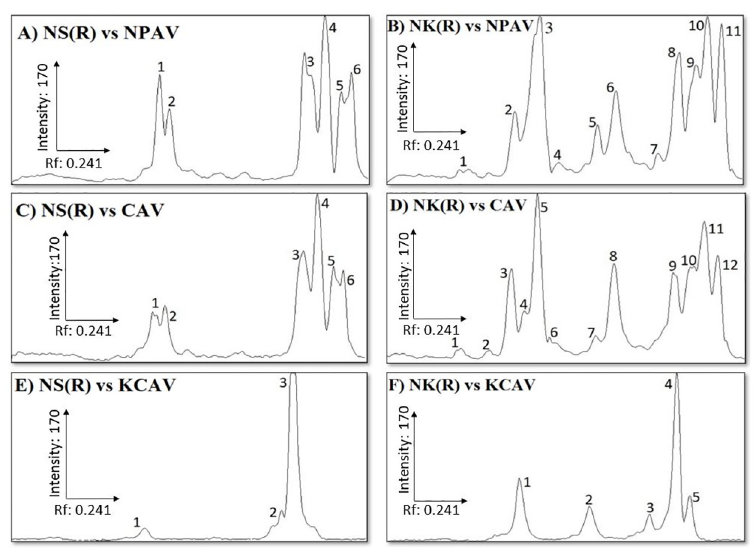
Fig 3. Densitogram for western blot of Malaysian Naja sumatrana and Naja kaouthia venoms. Panels (A-C) are desnsitograms for membrane blot of N . sumatrana venom that were incubated with Neuro Polyvalent Antivenom (NPAV), Monocled Cobra Antivenom (CAV) and King Cobra Antivenom (KCAV),respectively. Panels (D-E) are desnsitograms for membrane blot of N . kaouthia venom that were incubated with Neuro Polyvalent Antivenom (NPAV), Monocled Cobra Antivenom (CAV) and King Cobra Antivenom (KCAV), respectively NS(R) indicates reduced N . sumatrana venom and NK(R) indicates reduced N . kaouthia venom. Densitograms were generated using ImageJ software and the relative mobility for protein band (R f ) corresponding to the peak was manually calculated.